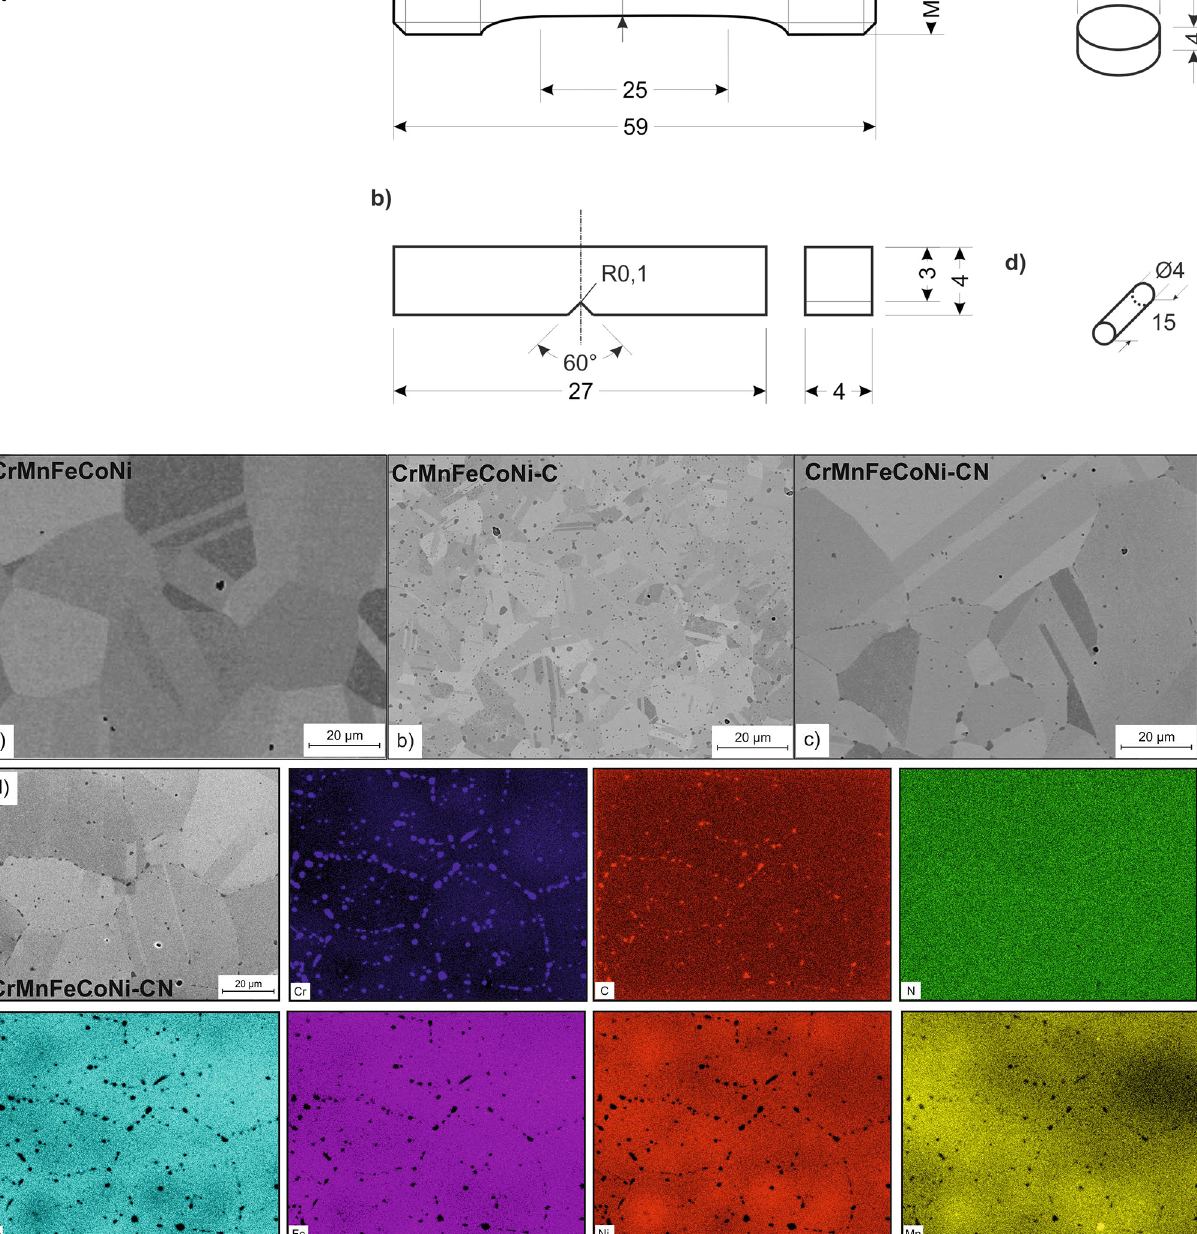
Fig. 2 SEM micrographs of the high-entropy alloys produced: a CrMnFeCoNi, b CrMnFeCoNi-C, c CrMnFeCoNi-CN. d EDS map of the CrMn- FeCoNi-CN